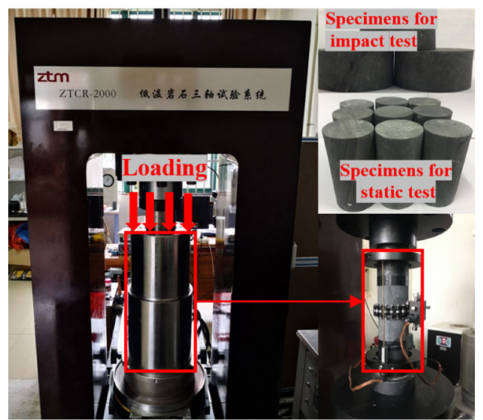
Figure 1. Mudstone samples and the static load test device.